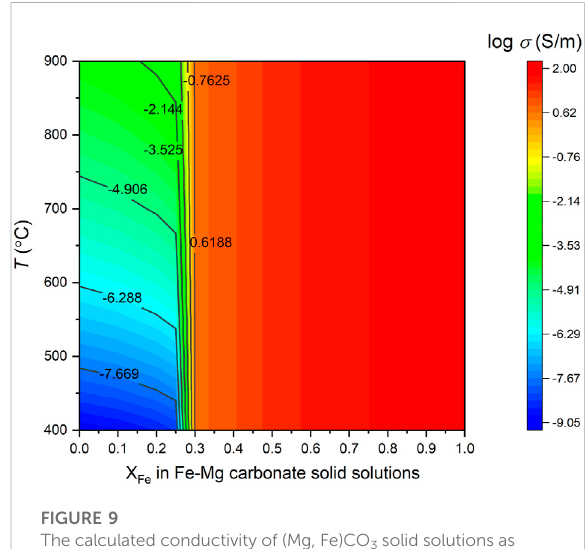
FIGURE 9 The calculated conductivity of (Mg, Fe)CO 3 solid solutions as a function of various Fe content in the temperature range of 400 – 900 ° C and at 2 GPa using the EM model. The numbers shown in the contour lines are the logarithmic